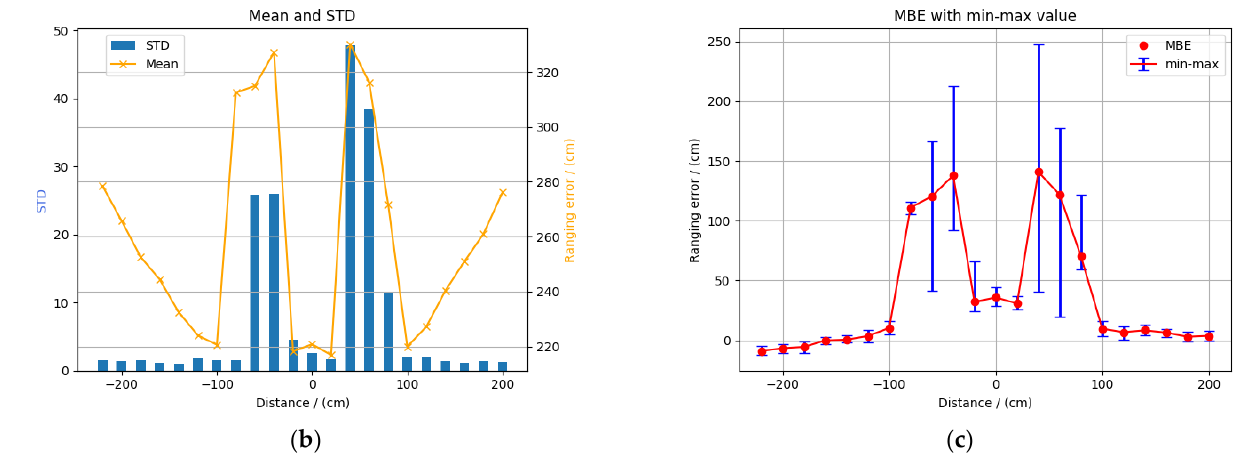
Figure A6. Ranging in NLOS condition. ( a ) Frequency distribution histogram of ranging data; ( b ) means and STDs of range errors; and ( c ) MBE and min – max value of ranging data.